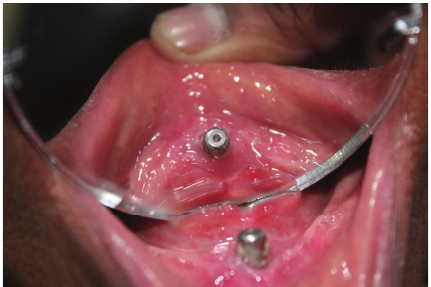
Figure 1: Healing after 6 weeks. Figure 2: Metal mesh adapted on the master cast.